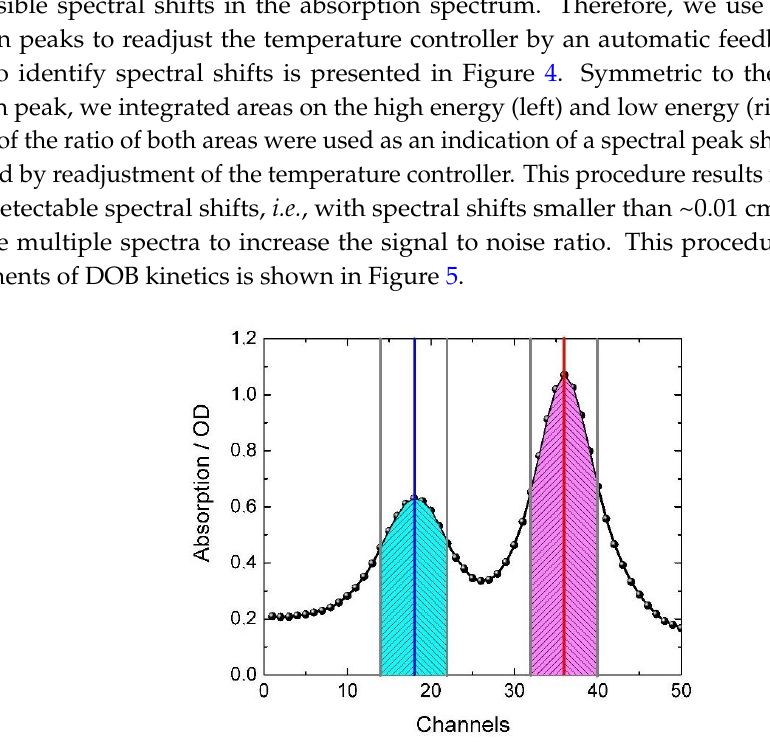
Figure 4. Absorption spectrum measured by the voltage ramp [17]. The peak positions at channel 18 (blue line) and channel 36 (red line) reflect 12 CO 2 and 13 CO 2 absorption lines, respectively. This method can be used without calibration and conversion of channels to wavenumbers. Every datapoint defines a channel. Integrated areas, symmetric to the left and right of the absorption maxima of both peaks are highlighted (crosshatched areas). The ratio of crosshatched areas for each peak are used to identify peak position shifts. Presented absorption lines are crosshatched in Figure